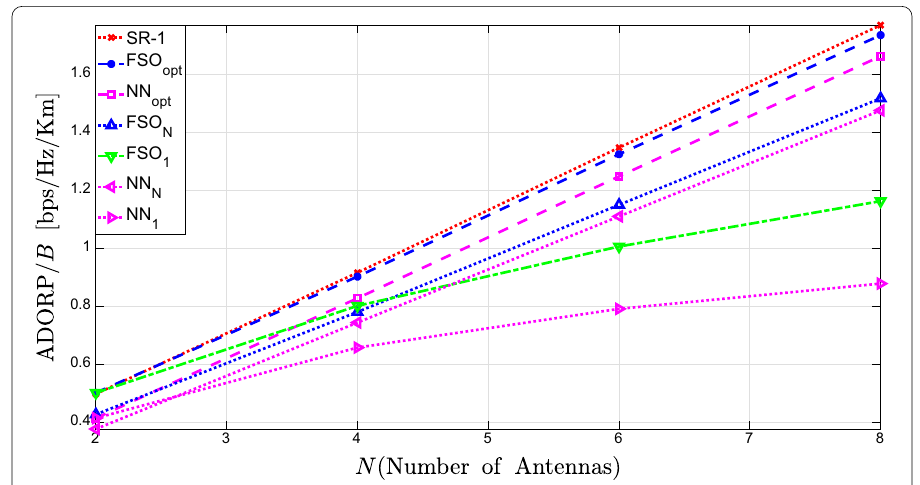
Fig. 6 Normalized ADORP vs. N = { 2,3,4,6,8 } (number of antennas) for a system with p tx = 0.25 , π r 2 RZ = 10 and α = 2.7 . The figure depicts the curves of the SR-1 scheme, the optimal FSO scheme ( FSO opt ) and the FSO schemes for FSO with single-stream transmission ( FSO 1 ) and full-stream transmission ( FSO N ), the optimal NN scheme ( NN opt ) and the NN schemes with single-stream transmission ( NN 1 ) and full-stream transmission ( NN N